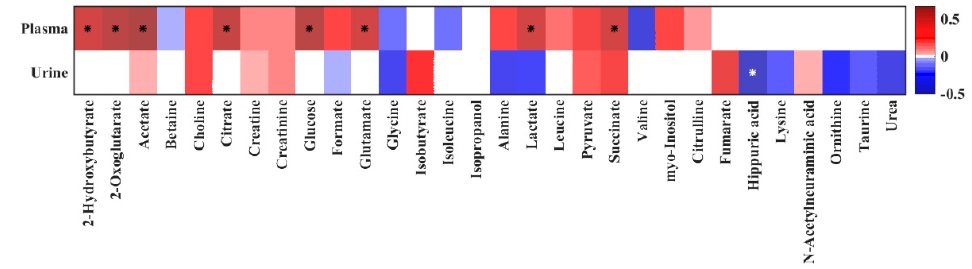
Figure 4. Heat map of correlation analysis between the quantified plasma and urine metabolites and quantified urine L/M ratio by 1 H NMR spectroscopy. Stars indicate significant correlations ( p < 0.05). The heat map is colored based on Pearson’s correlation coefficient (r). The red and blue color of every cell illustrates the Pearson’s correlation coefficient value, while deeper colors indicate higher positive (red) or negative (blue) correlation coefficients.